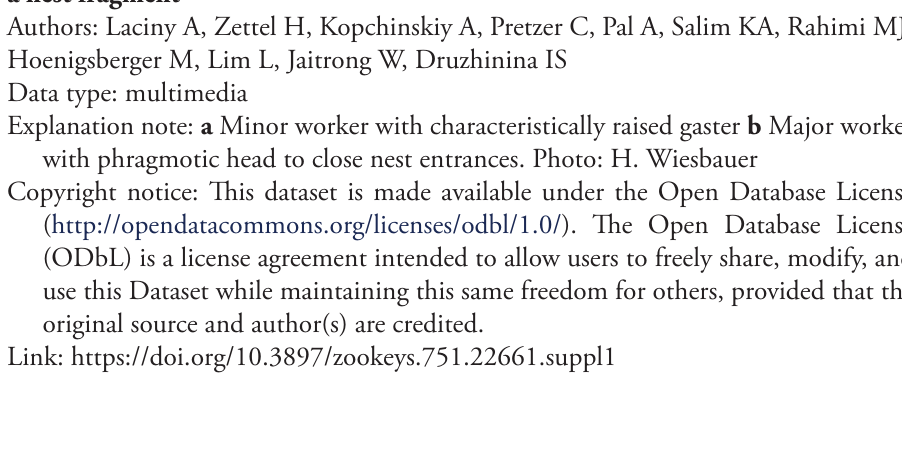
Figure S1. Living workers of C. explodens sp. n. on a detached branch containing a nest